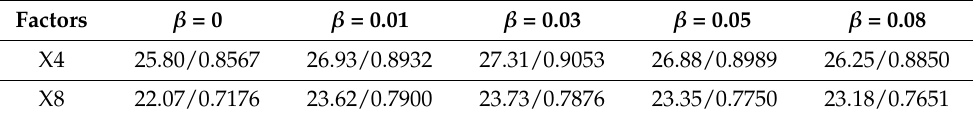
Table 4. Performance effect of the perturbation degree β on the Bicubic down-sampled LR images of the Set5 dataset.